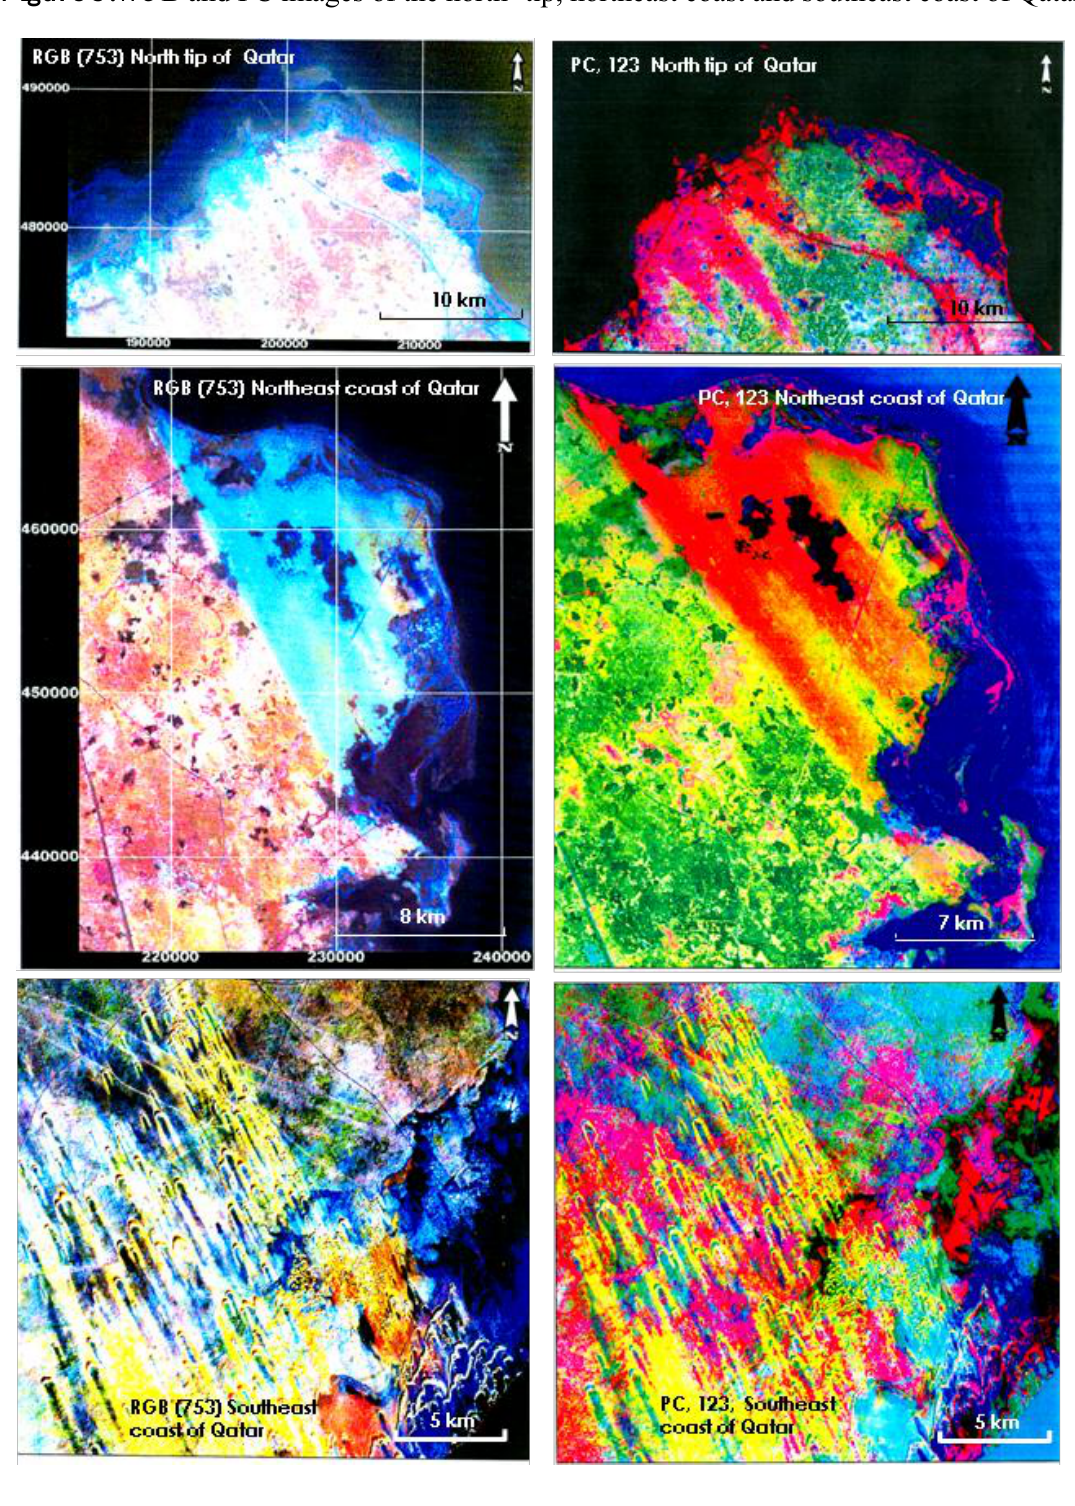
Figure 3. RGB and PC images of the north’ tip, northeast coast and southeast coast of